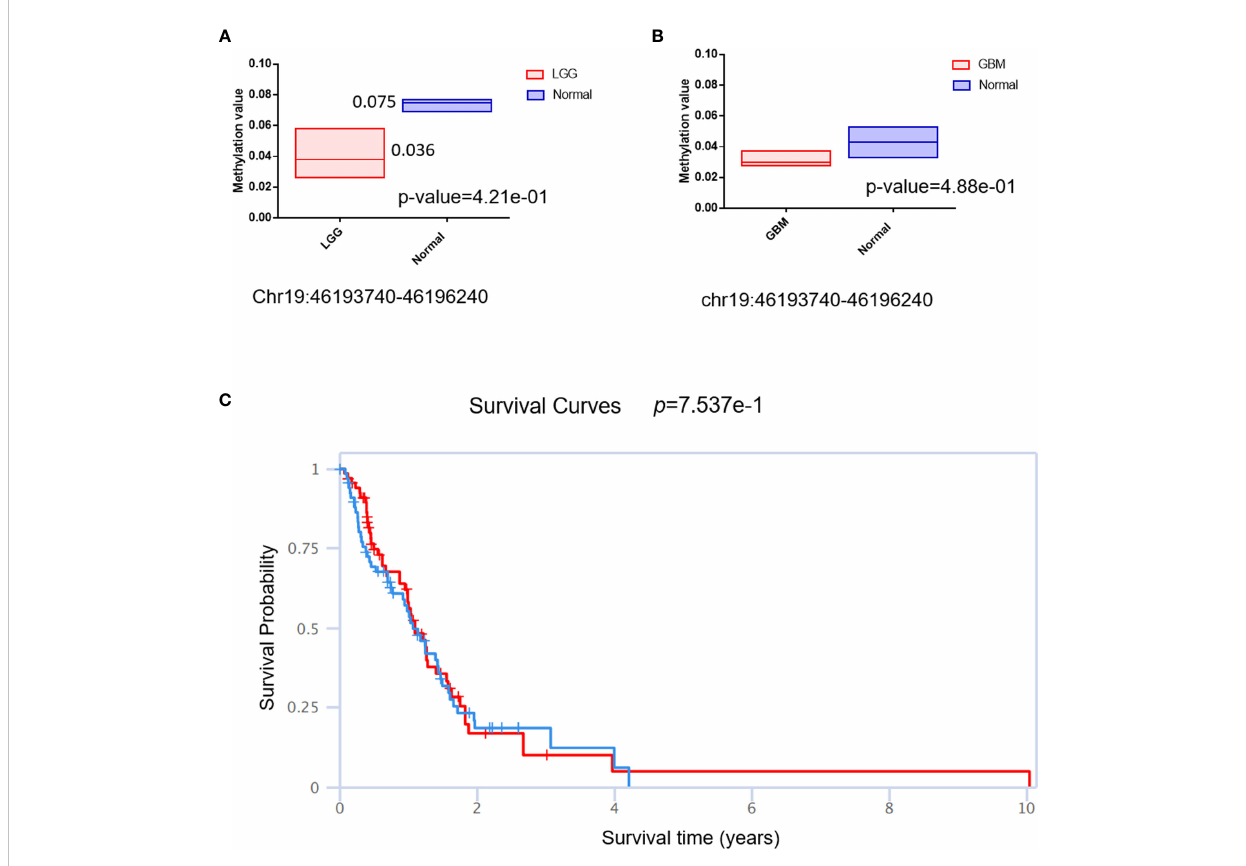
FIGURE 6 The DNA methylation status of QPCTL and its relationship with the glioma patients ’ survival. (A) The DNA methylation level of QPCTL in LGG patients and normal people. (B) The DNA methylation level of QPCTL in GBM patients and normal people. (C) The correlation between the DNA methylation of QPCTL and the GBM patients ’